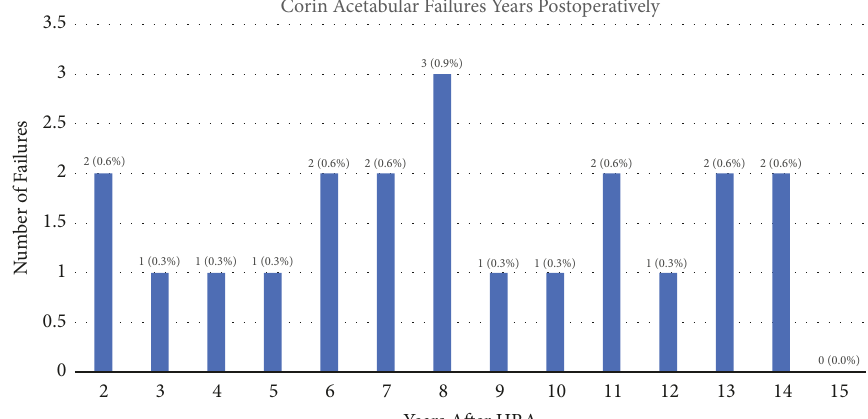
Figure 3: Corin late acetabular failure distribution over postoperative time. Figure 3 presents a distribution of Corin acetabular failures over postoperative time. Callouts show number of failures and percentage of the entire cohort (371 cases). Two cases failed before 2 years postoperatively (0.5% of cases) and are considered failure of